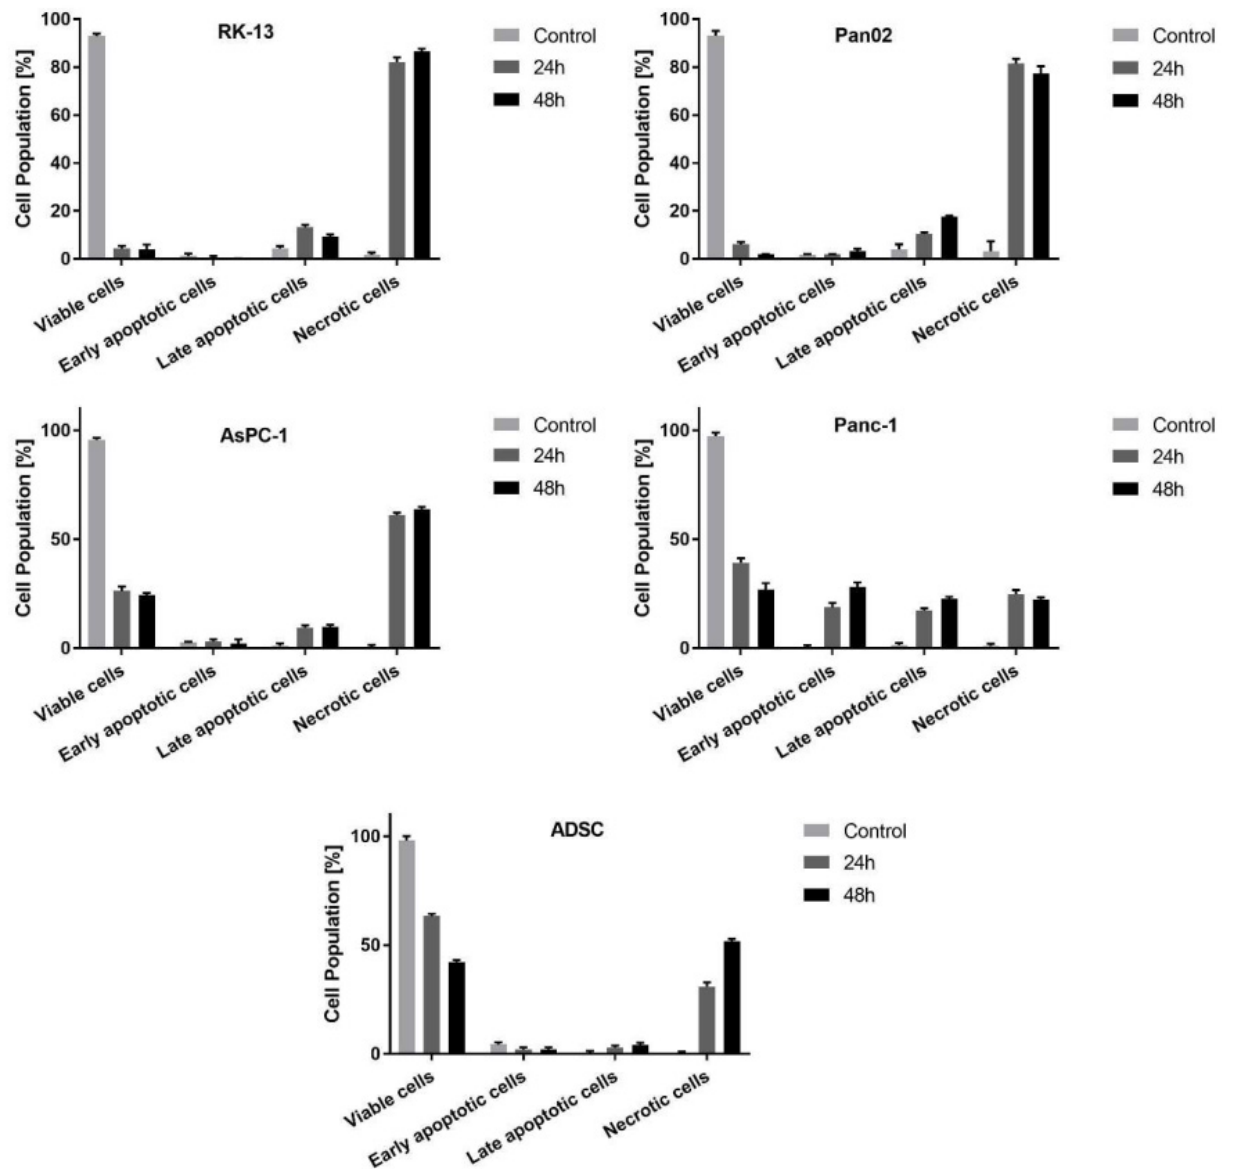
Figure 2. Examination of apoptosis and necrosis in cell lines: RK-13, Pan02, AsPC-1, Panc-1 and ADSCs infected with vMyx-LIGHT (MOI = 5) at 24 and 48 h after infection; flow cytometry, Annexin V (FITC channel) and 7-AAD (PerCP-Cy5.5 channel). The data show mean ± SD of two independent experiments.